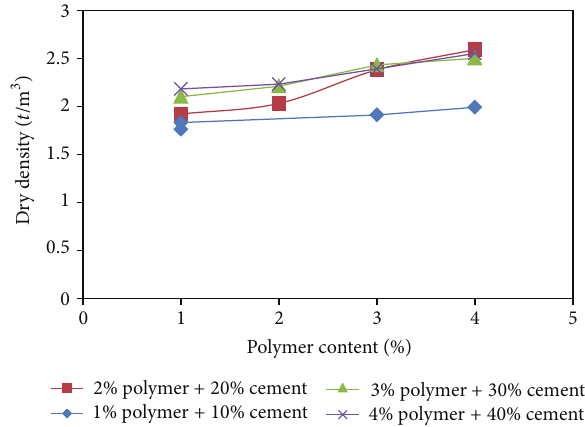
Figure 9: Effect of polymer content on maximum dry density of soil in wet conditions for 7